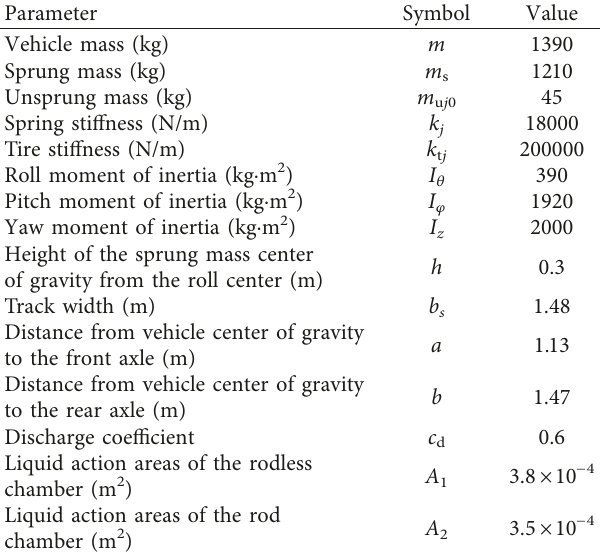
Table 4: Parameter values for the HIS-based semiactive control